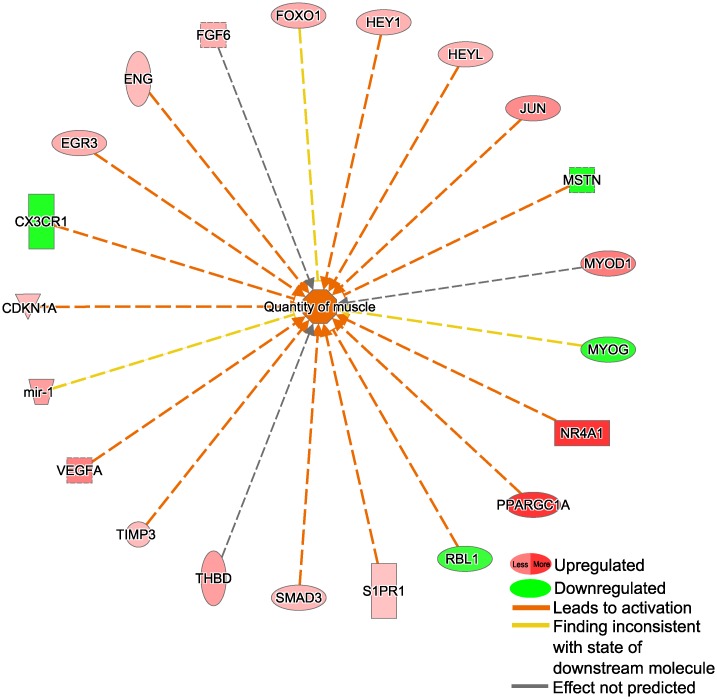
Sprint exercise—Induced changes in gene expression related downstream biofunction.Differentially expressed genes related to the predicted downstream function ‘quantity of muscle’ are depicted. The figure was created using IPA-tools.